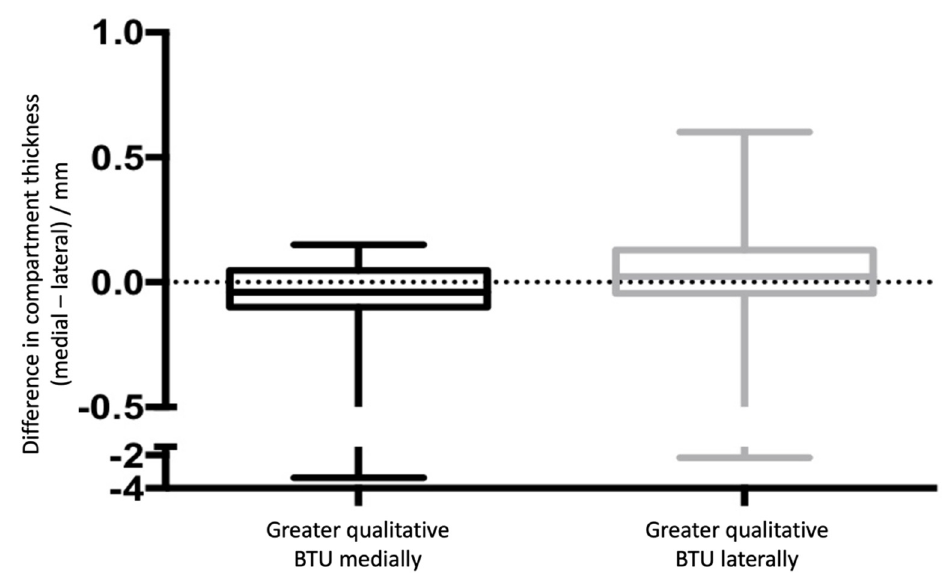
Figure 5. Box plot showing the medial and lateral compartment thickness for the two groups in which either the medial or lateral side was found to have a greater BTU from analysis of SPECT/CT imaging. A negative value on the y-axis indicates that the medial compartment was thinner; a positive value indicates that the lateral compartment was thinner.